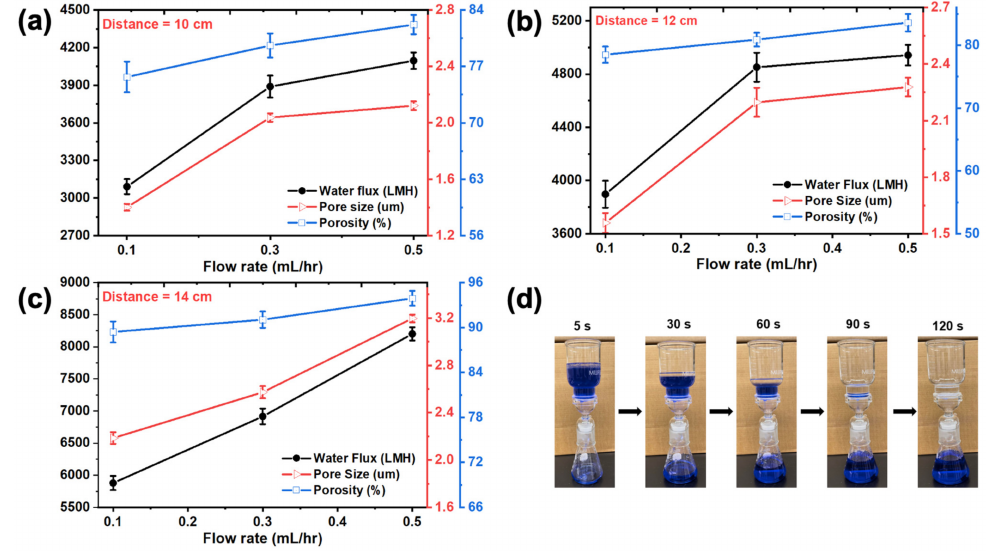
Figure 6. 27EVOH_22% ENM properties at different flow rates and distances between the collector and needle: ( a ) 10 cm, ( b ) 12 cm, and ( c ) 14 cm. ( d ) Visuals of the separation process completed in 120